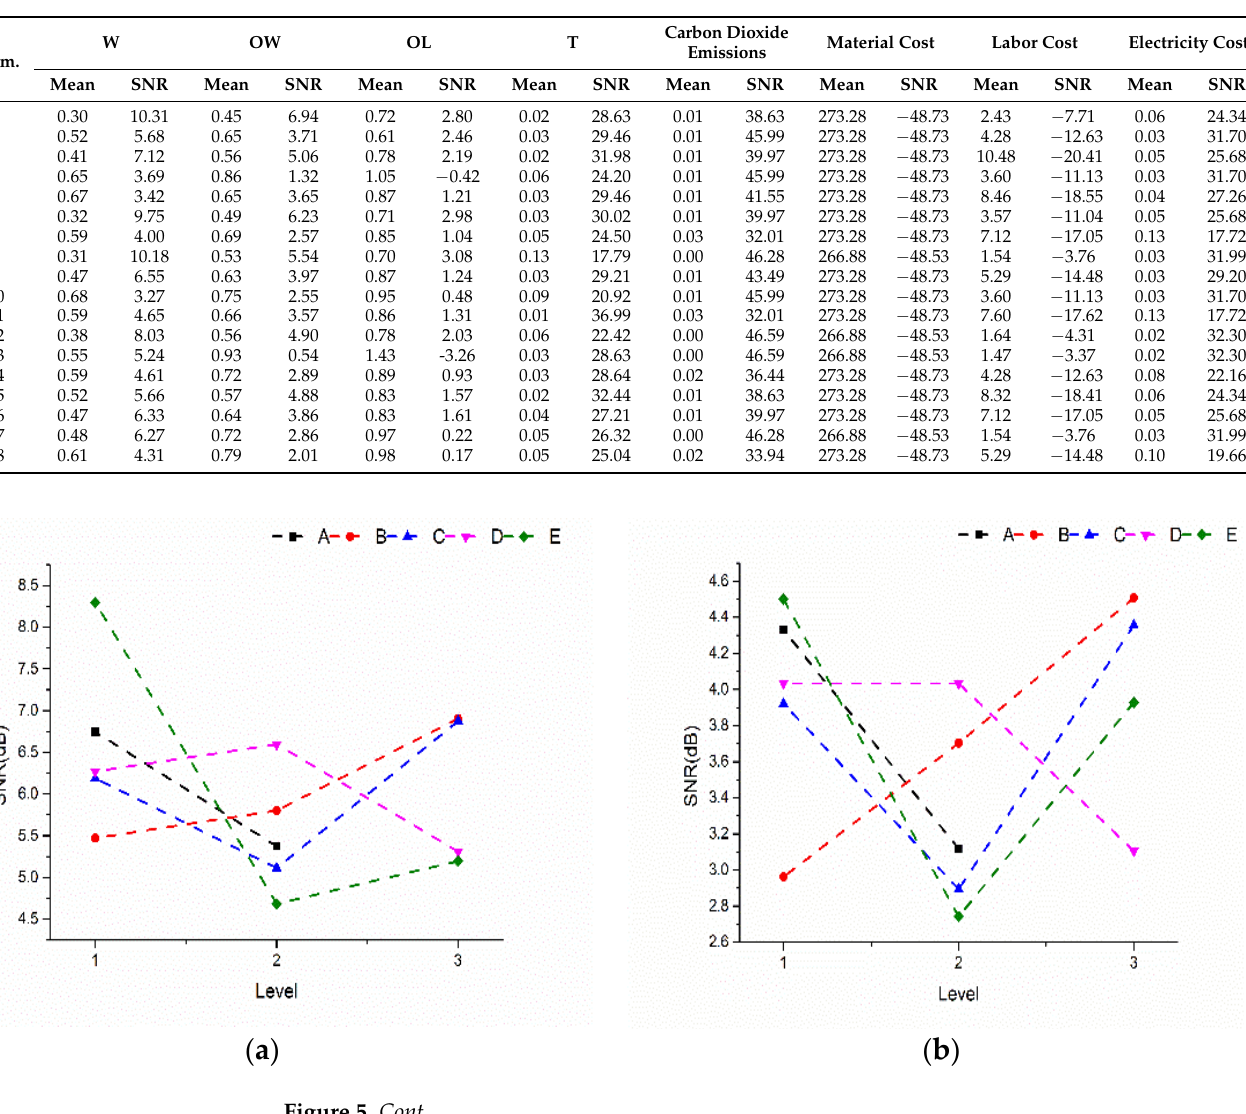
Table 4. Mean values and S/N ratios of the experimental results.